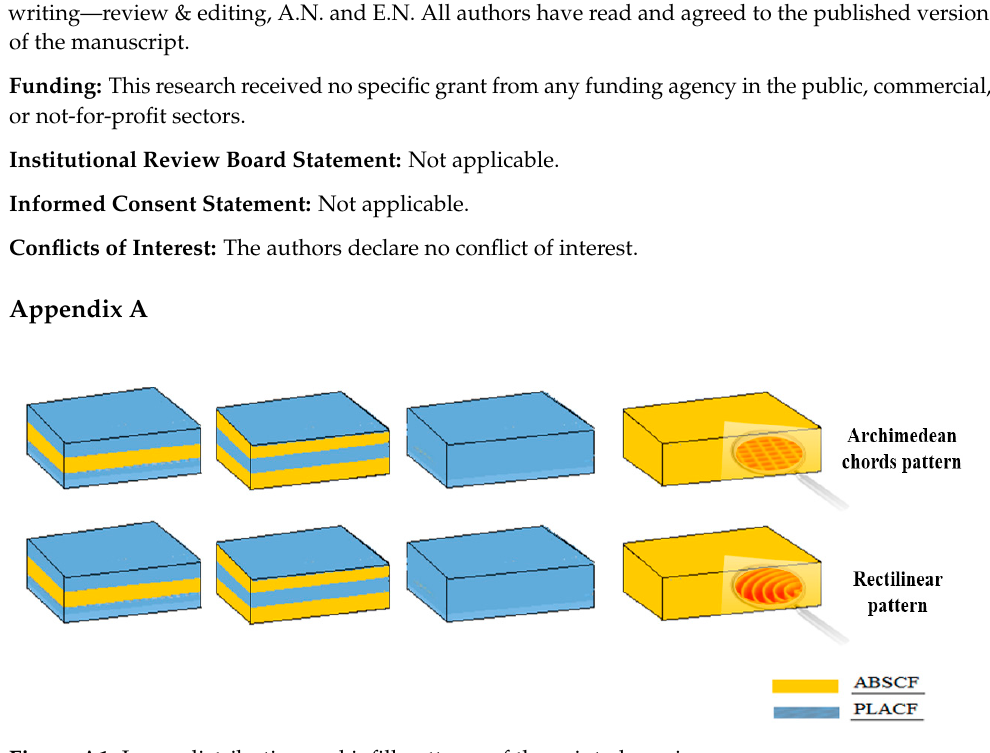
Figure A1. Layer distribution and infill patterns of the printed specimens.